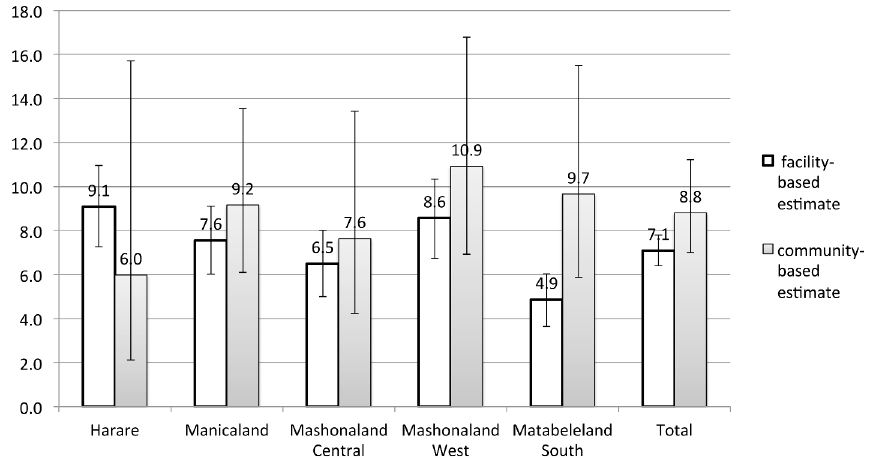
Fig 5. Mother-to-child HIV transmission rate by province, estimated by the community survey and by Zimbabwe ’ s National Health Information System using facility-based monitoring and evaluation data. The community survey was conducted in May-September 2012 and enrolled babies aged 9 to 18 months, while the facility-based data consists of early infant testing conducted in January-December 2012 among babies mostly < 4